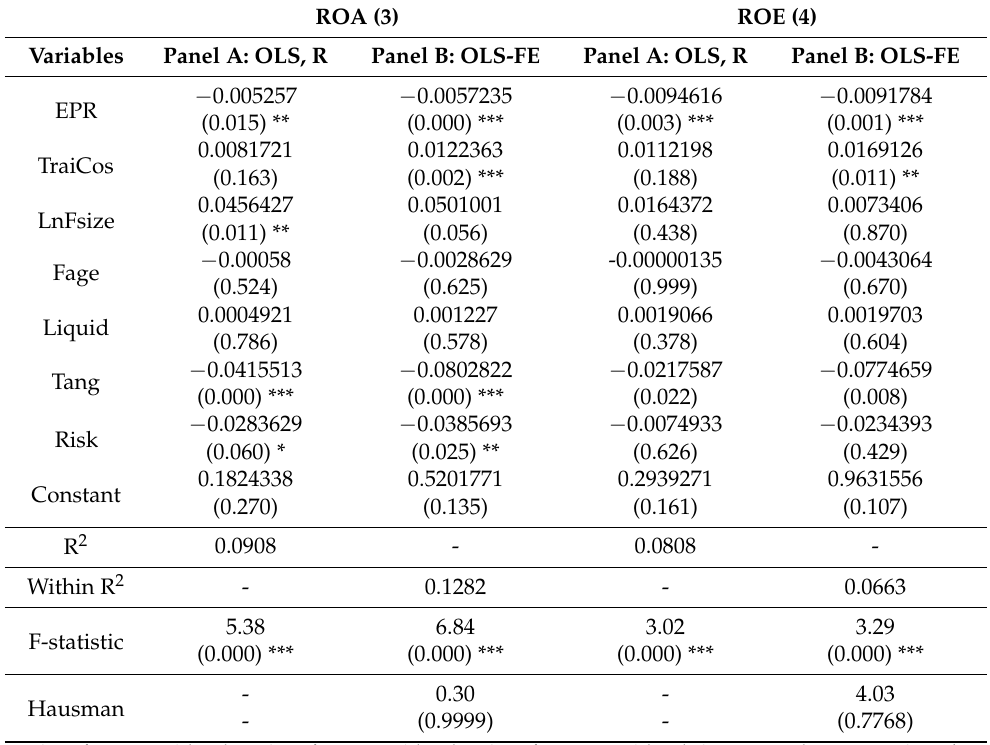
Table 6. Regression analysis of model (3) and